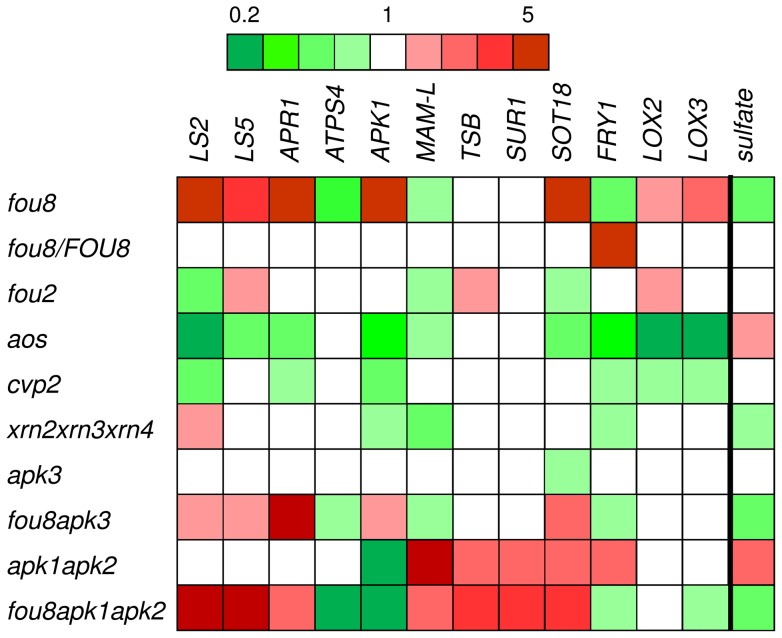
Expression analysis of Arabidopsis lines.The various Arabidopsis lines were grown for 5 weeks in controlled environment room. Total RNA was isolated from leaves and the transcript levels of genes involved in sulfur metabolism, glucosinolate synthesis, and jasmonate synthesis were determined by quantitative RT-PCR. The qRT-PCR reactions were performed in triplicate for each of the six independent biological samples from plants grown in two independent experiments. Results are presented as a heat map of relative mRNA levels compared to Col-0. For comparison, sulfate levels are presented in the same way on the far right.